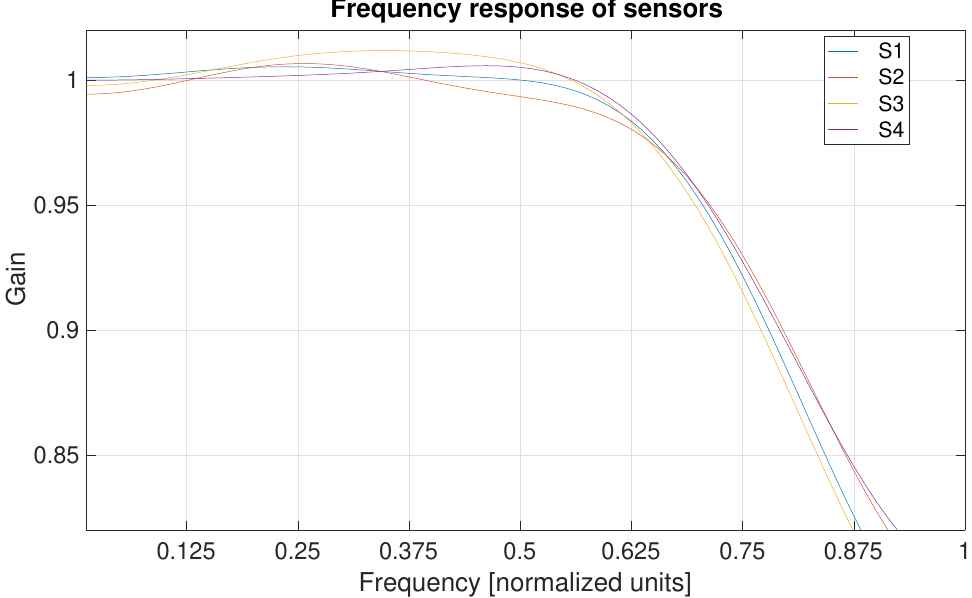
Figure 2. Amplitude frequency response of the adopted sensors; the values of the frequency are ex- pressed in units normalized to the bandwidth of the system, and range from 0 up to 1. All responses are characterized by 3 dB cut-off normalized frequencies that fall in the interval (0.93–0.97) with a 95% con- fidence level; all frequency responses grant flatness within 0.18 dB up to 0.625 normalized